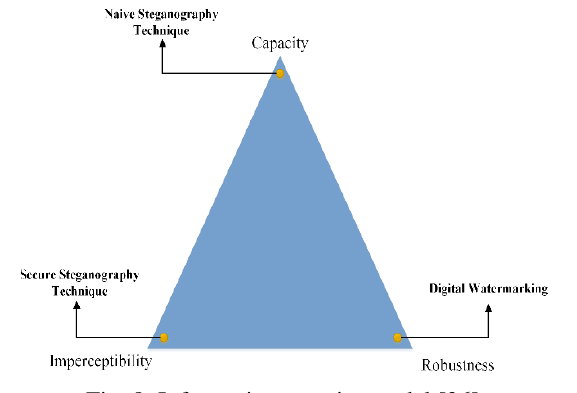
Fig. 8: Information security model [36]